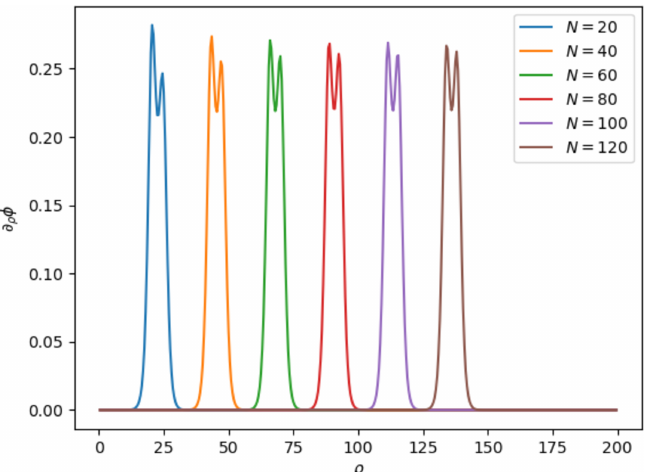
Figure 14 . The radial derivative of the vortex field for vortons with various winding numbers (but fixed Q/N) using parameter set B. There is an asymmetry around the vorton radius (the local minima inside each peak) which is reduced for larger vortons. Again, this is consistent with curvature corrections to the thin string approximation.